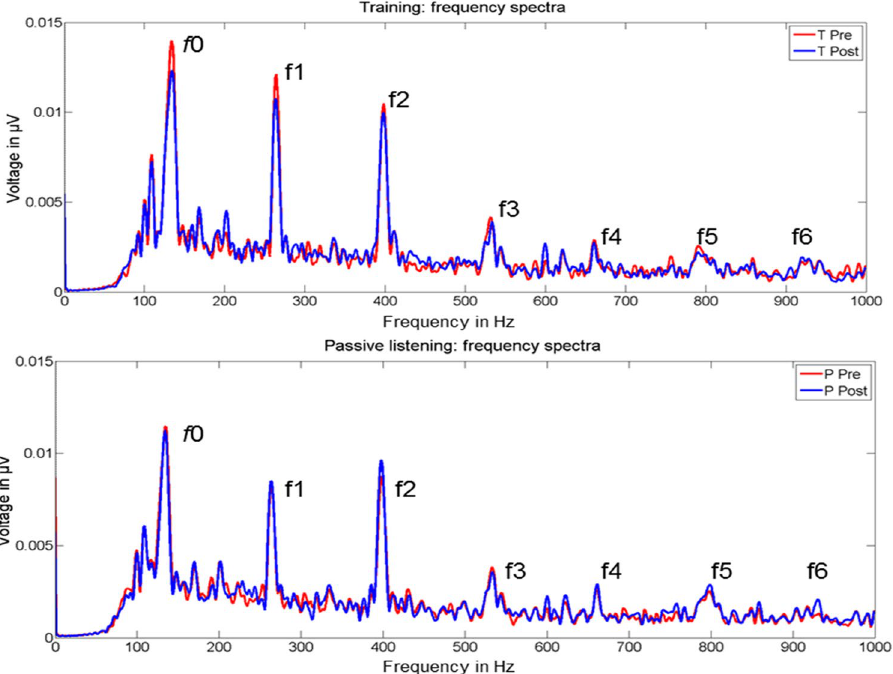
Figure 3. Grand-average FFR power spectra (i.e., subtracted polarities) at T0 (pre, red line) and T1 (post, blue line) of the TG (upper part) and PG (lower part). f 0 = fundamental frequency, f1–f6 =